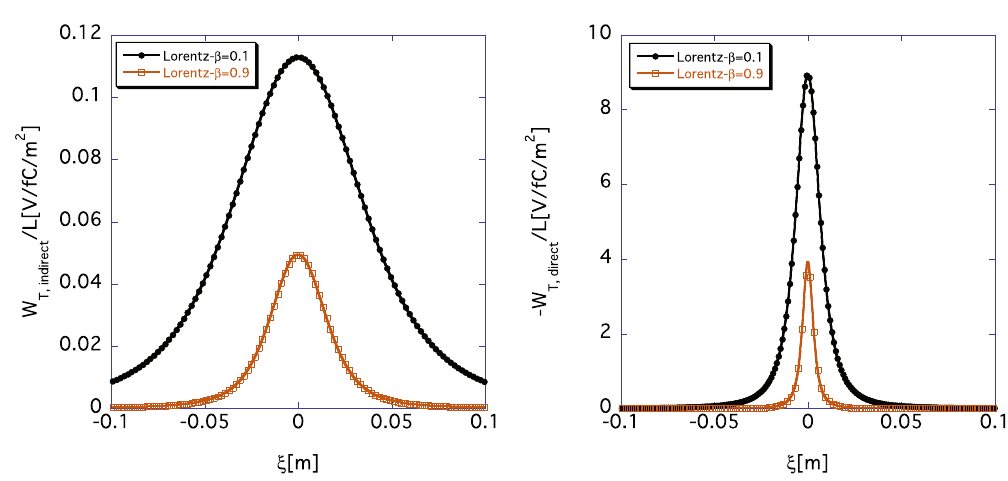
Figure 4. Lorentz- β dependence of indirect space-charge wake function W T , indirect ( ξ ) according to Eq. (25) (left) and direct one W T , direct ( ξ ) according to Eq. (24) (right), where σ z = 0, r b = 10 mm, and a = 40 mm. The black and brown lines show the wake functions for β = 0.1 and 0.9,